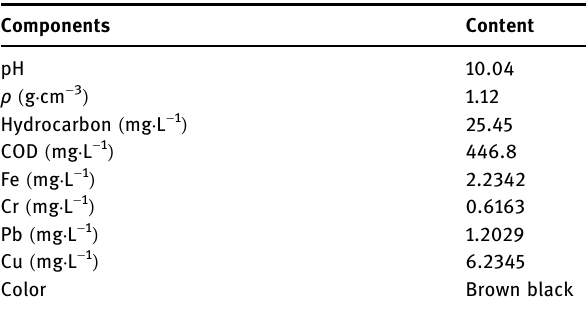
Table 3: Analysis of main properties and pollutants of the waste water - based drilling fl uid Components